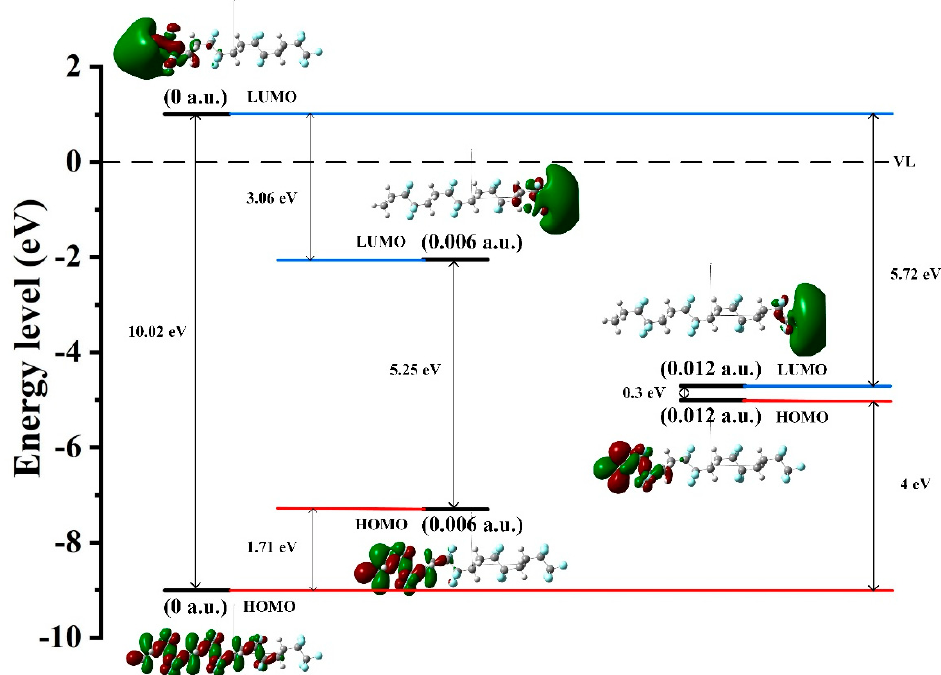
Figure 9. The energy level distribution and the frontier orbital of PVDF.